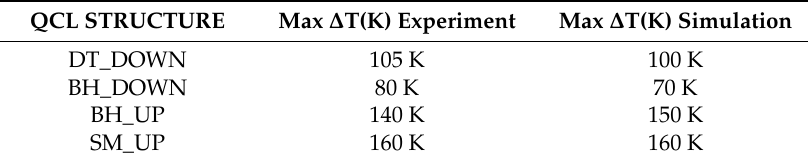
Table 2. The experimental and calculated temperature increases for different types of laser design